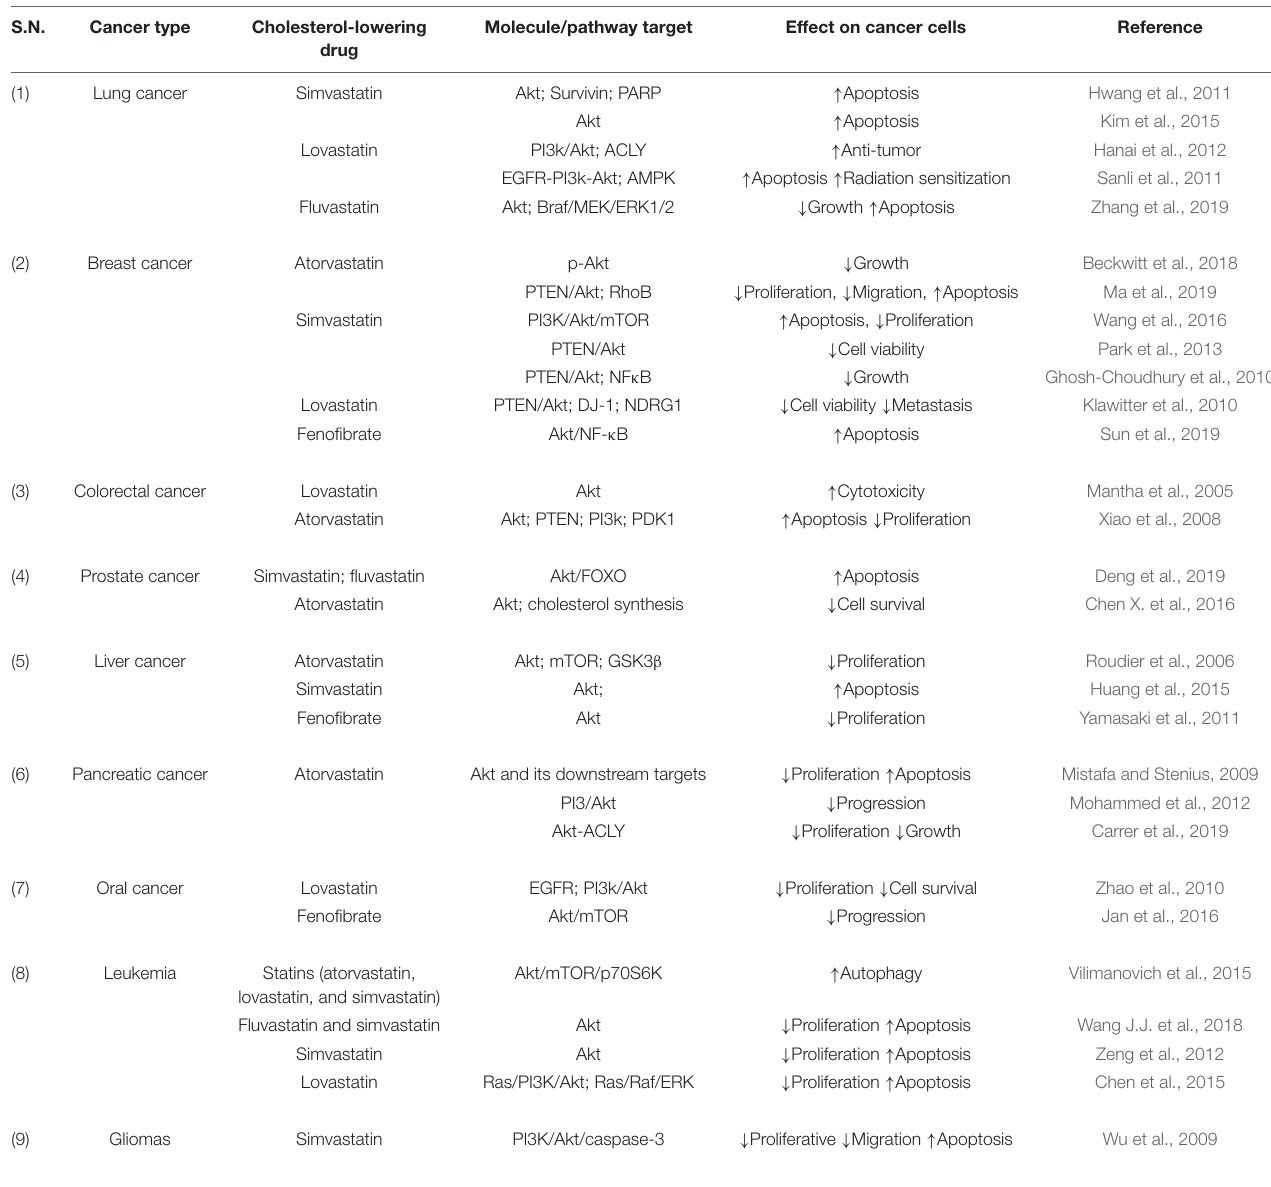
TABLE 2 | Anti-tumorigenic effects of cholesterol-lowering drugs by targeting Akt and associated molecules.